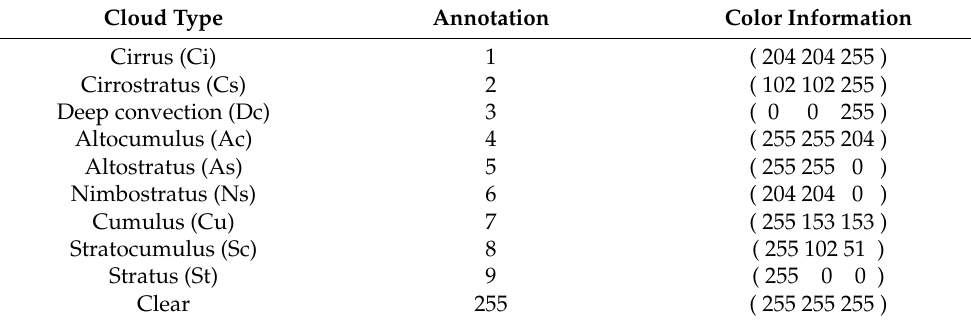
Table 6. Annotation and color information of cloud types.